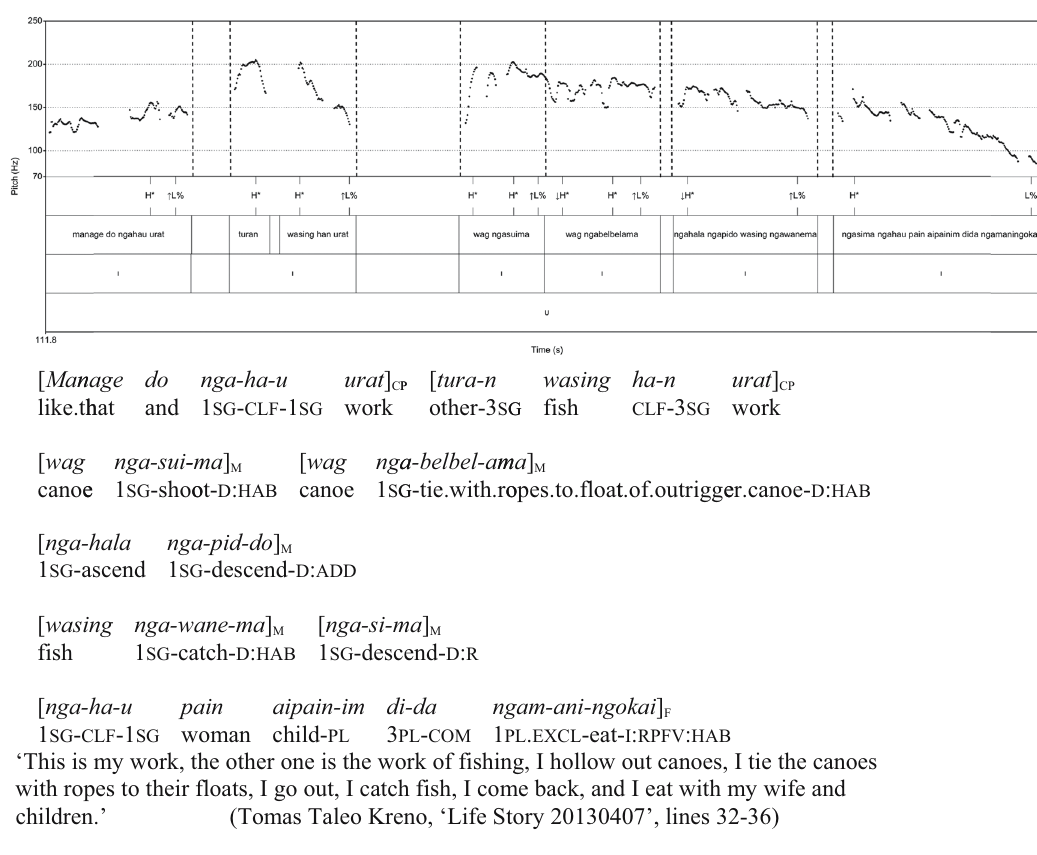
Figure 4: Clause chain with medial ↑ L% tones and fi nal L%